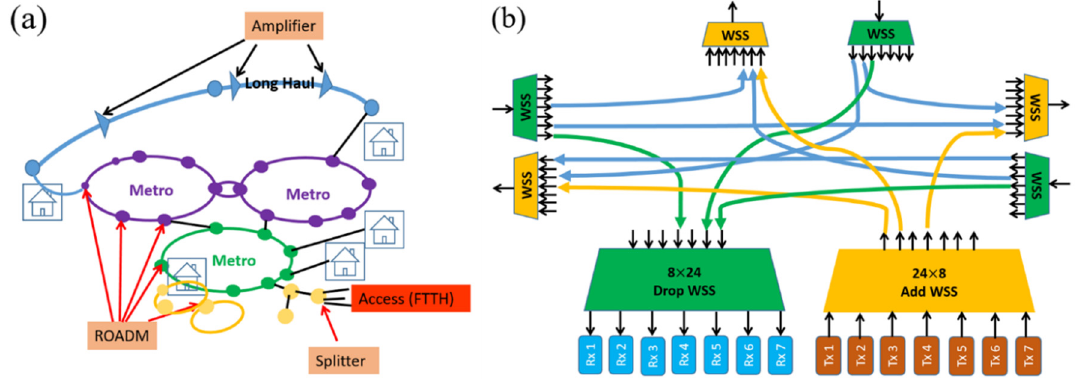
Figure 1. ( a ) Schematic diagram of optical telecommunication network; ( b ) Example of ROADM architecture.